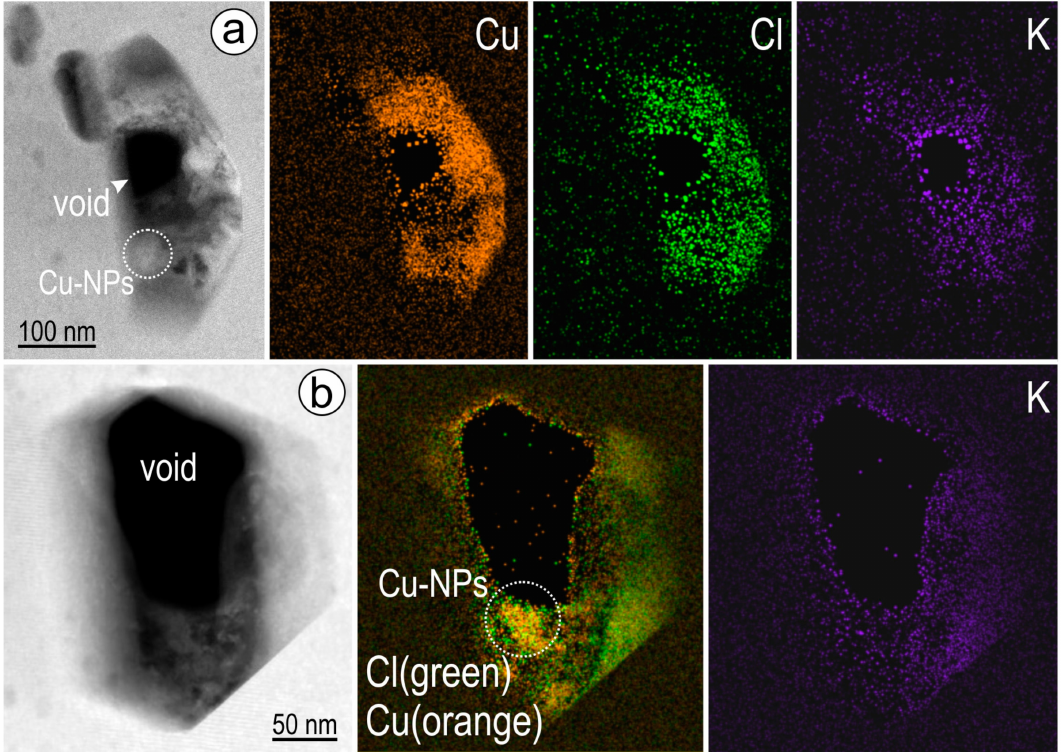
Figure 8. HAADF STEM images (left) and STEM EDX maps (extended maps in Supplementary Material Figures S4 and S5; foil #1–2 in ( a , b ), respectively) showing native Cu NPs within negative crystal shaped cavities from domain A. Note the presence of Cl and K within the